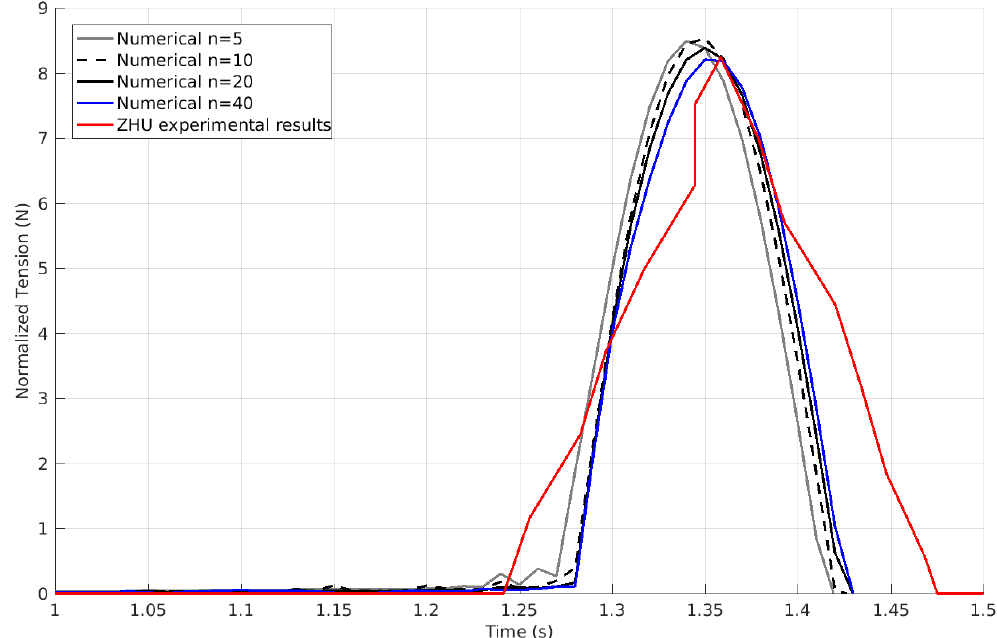
Figure 8. Detailed numerical results for different number of nodes compared with experimental